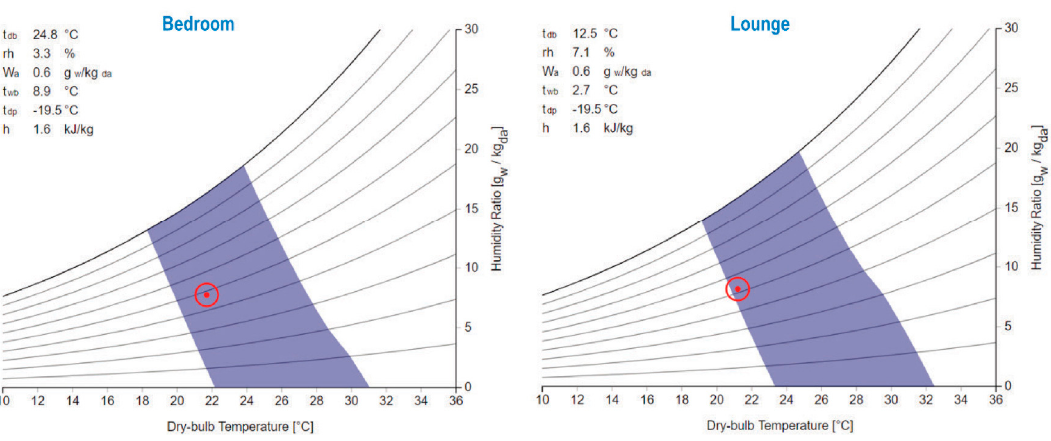
Figure 6. Thermal condition of the bedroom ( left ) and lounge space ( right ) in psychometric chart. The shaded areas represent comfort zone boundary [24].